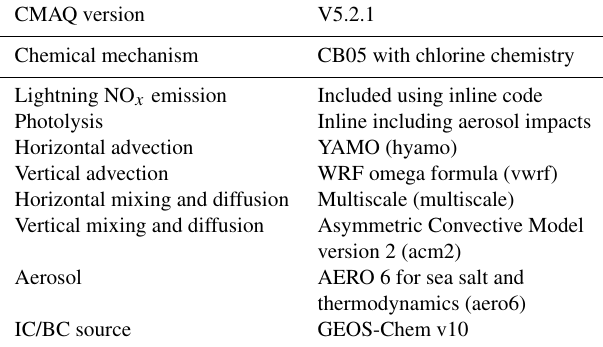
Table 1. CMAQ major configurations.